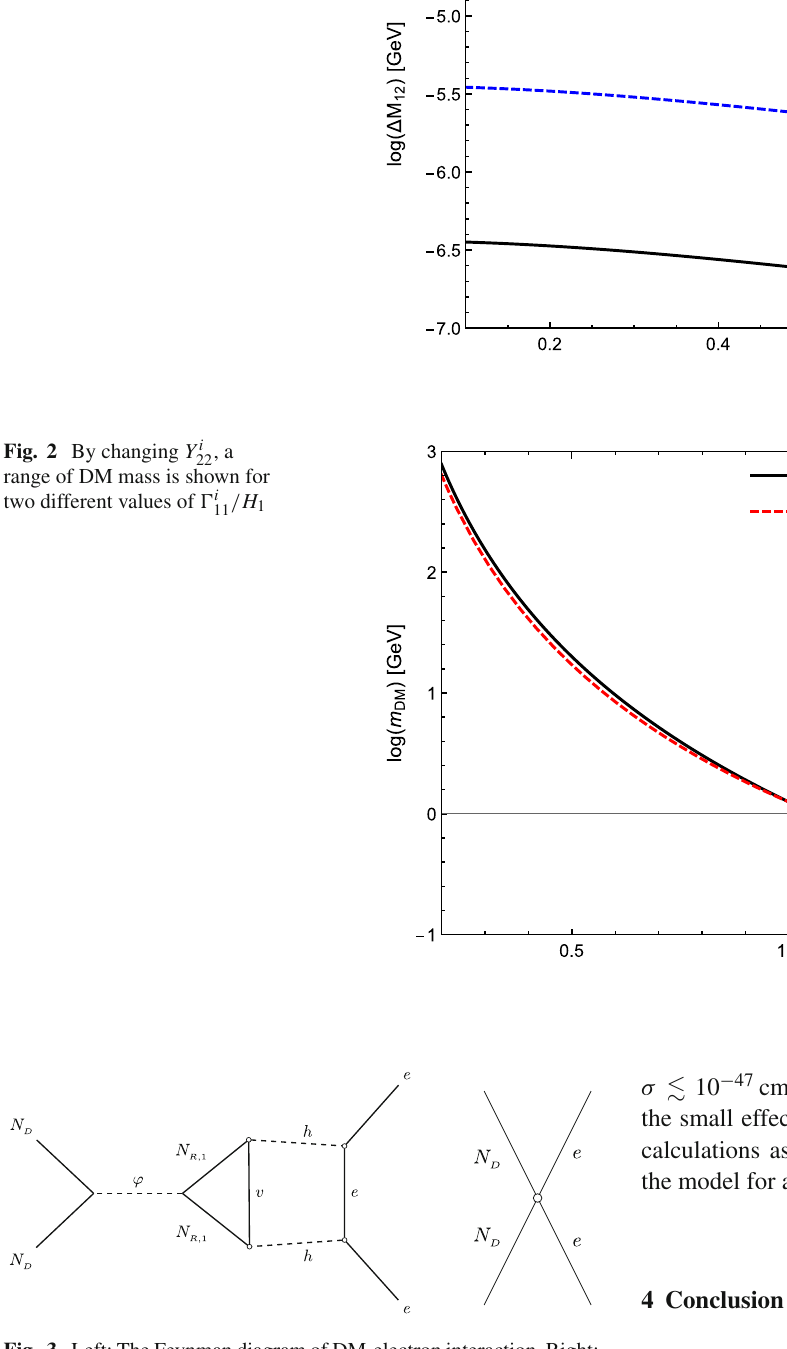
Fig. 3 Left: The Feynman diagram of DM-electron interaction. Right: The induced interaction at low-energy with the effective coupling